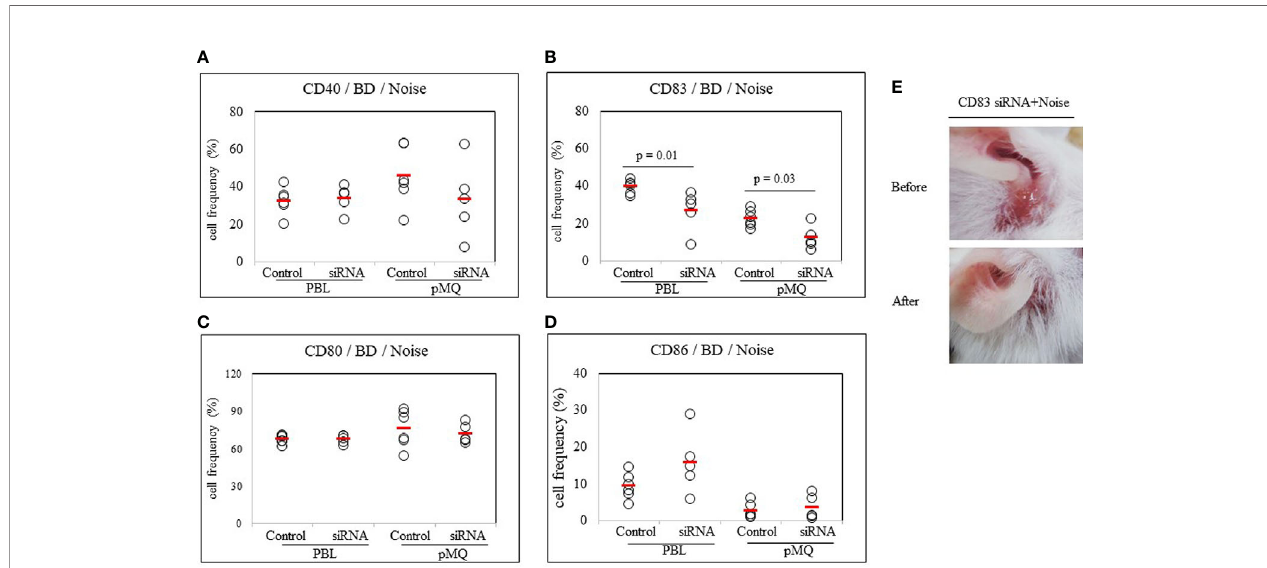
FIGURE 7 | CD83 siRNA reduces frequencies of CD83+ cells in BD mice. Both noise stress and CD83 inhibition were used to treat BD mice at the same time. Symptoms were improved and frequencies of CD83+ cells were decreased in the group that showed inhibition of CD83 after treatment with CD83 siRNA. BD mice were treated with noise stress and CD83 inhibition at the same time and changes in symptoms and frequencies of DC activation markers were analyzed (A – D) . In the group that showed inhibition of CD83 after treatment with CD83 siRNA, frequencies of CD83+ cells were decreased (B) . CD83 siRNA inhibited the increase in frequencies of CD83+ cells induced by noise stress and inhibited the deterioration of BD symptoms (E) . For statistical analysis, Mann-Whitney U test was performed. Experiments were conducted independently at least three